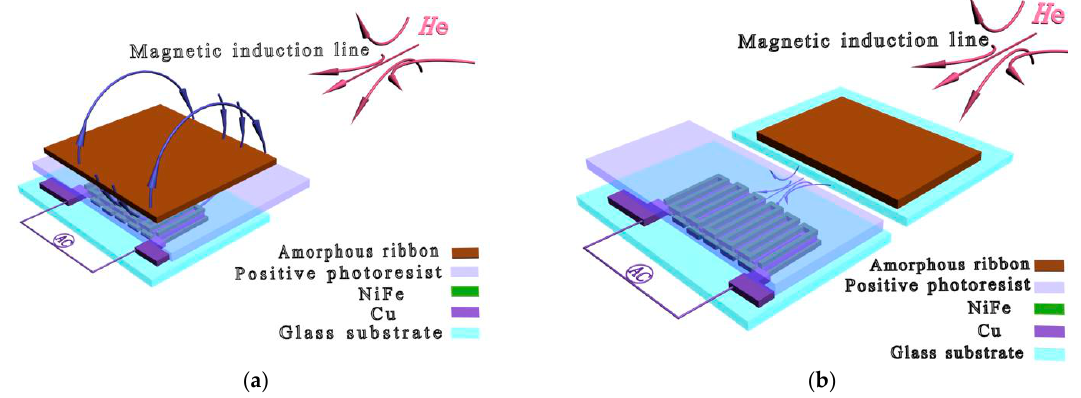
Figure 3. Two simple methods for detection of the stray magnetic fields of soft ferromagnetic amorphous ribbons: ( a ) the ribbon is immobilized on the top of the giant magnetoimpedance sensor and ( b ) the ribbon is immobilized in front of the giant magnetoimpedance sensor. Adapted from [9].